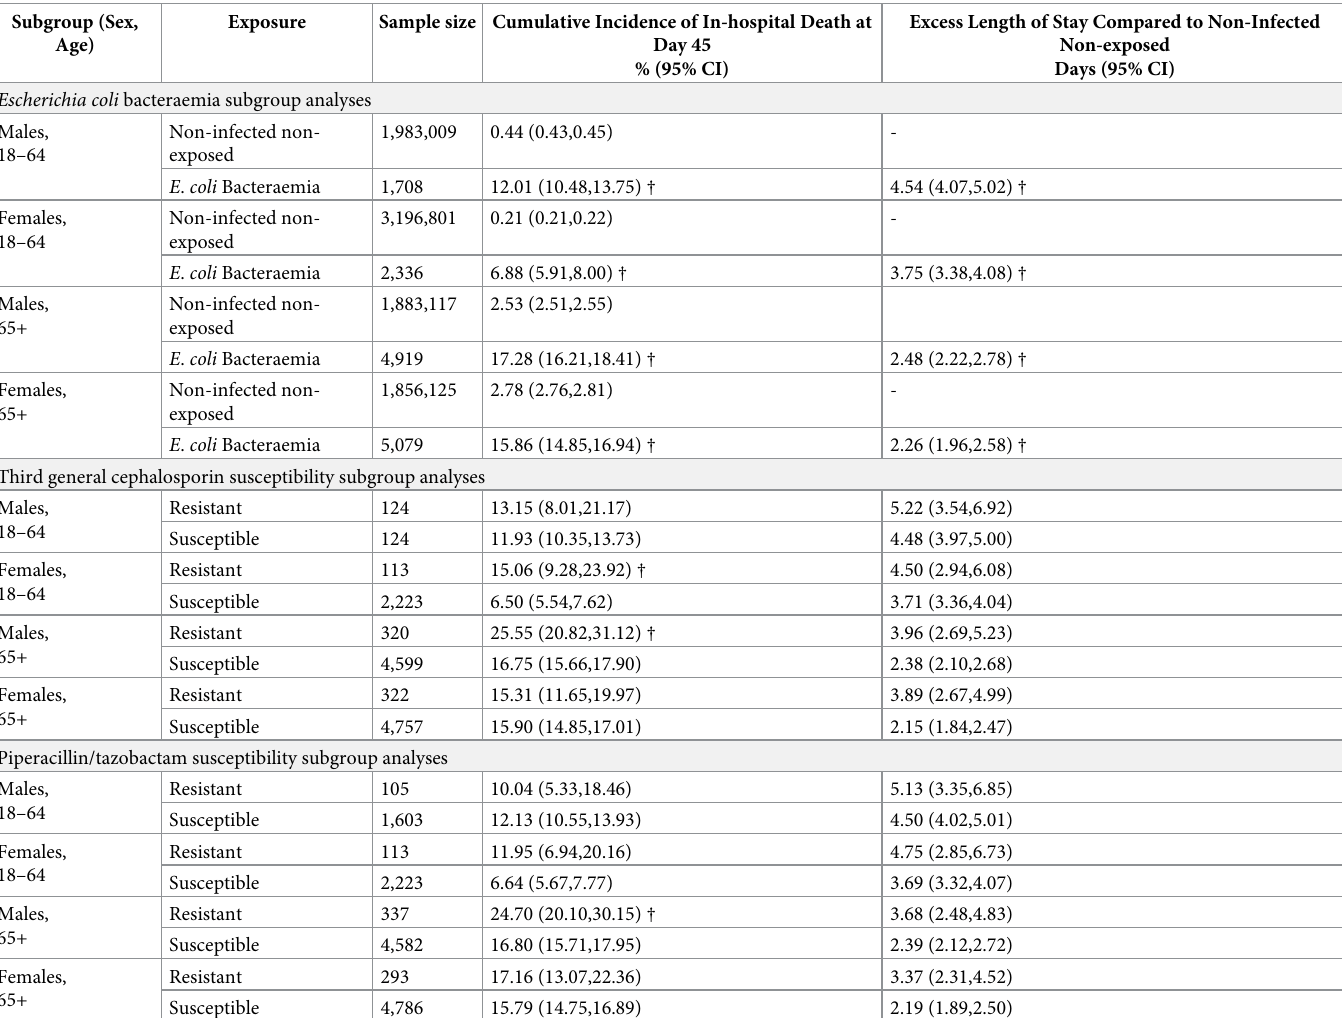
Table 6. Subgroup analyses of in-hospital mortality and length of stay